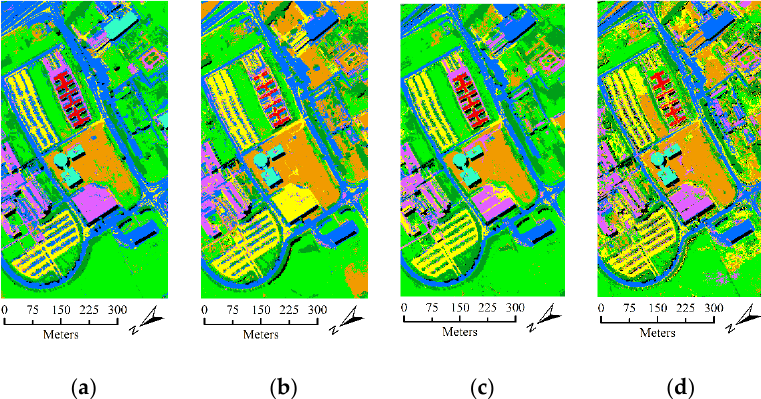
Figure 15. Classification maps obtained by using different strategies to ensure confidence for Pavia University dataset: ( a ) with SC and ASR (95.85%); ( b ) with SC (91.72%); ( c ) with ASR (93.04%); and, ( d ) without SC or ASR (86.03%).